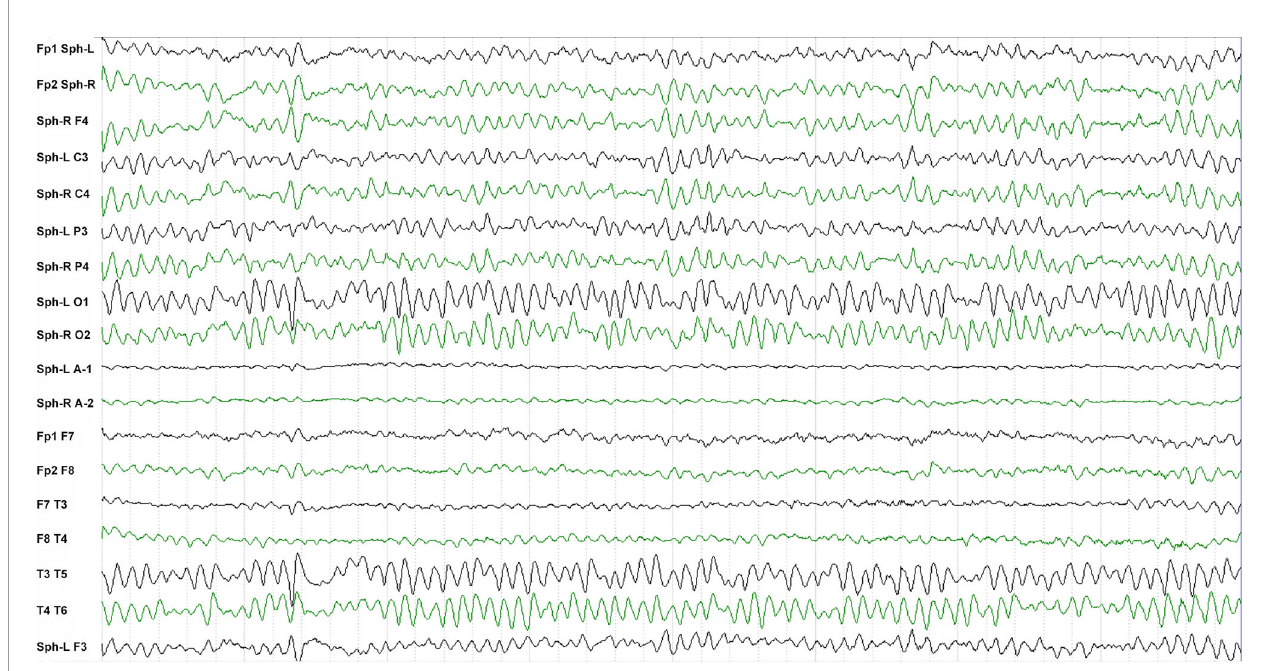
FIGURE 2 | Typical EEG of a patient with anti-LGI1 encephalitis. The inter-ictal EEG of a patient shows sharp-wave activity in the sphenoid